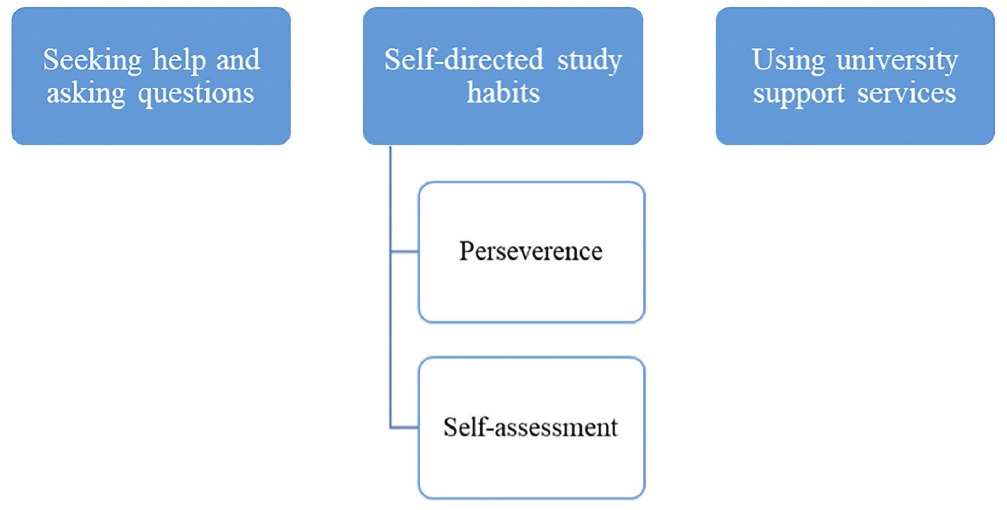
Figure 1. Themes Relating to Learning